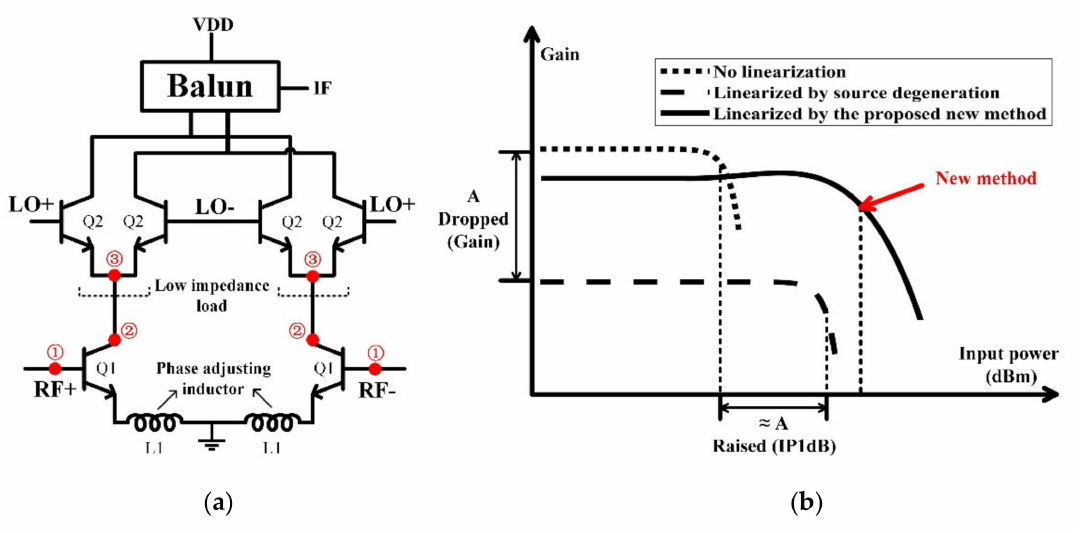
Figure 9. ( a ) The proposed mixer. ( a ) Schematic of the main circuit, ( b ) comparison of the proposed method and source degeneration.